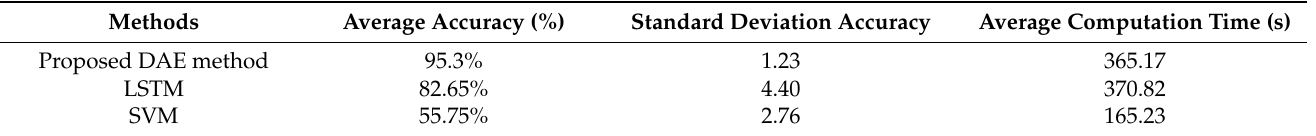
Table 3. Average testing accuracy and computation time comparison of the 3 methods.